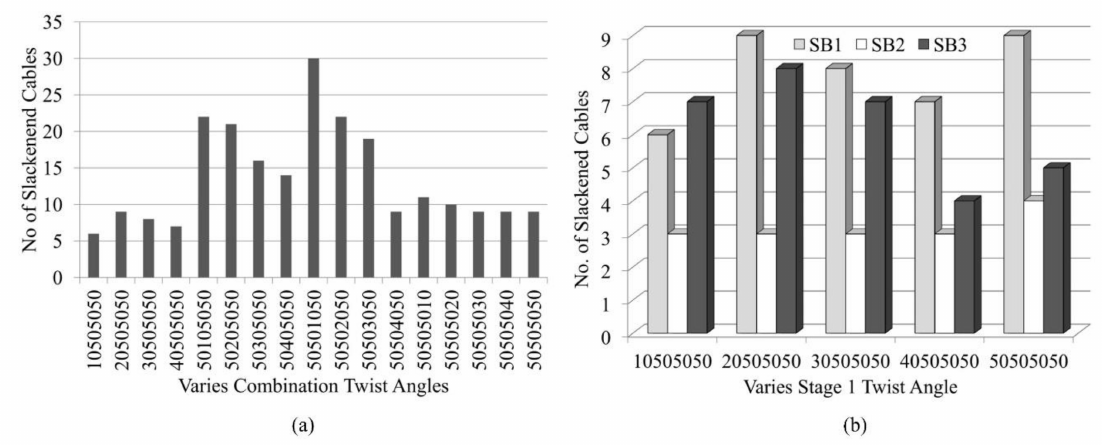
Figure 12. E ff ect of various combinations of twist angles on number of slackened cables for ( a ) SB1 and ( b ) SB1, SB2 and SB3.